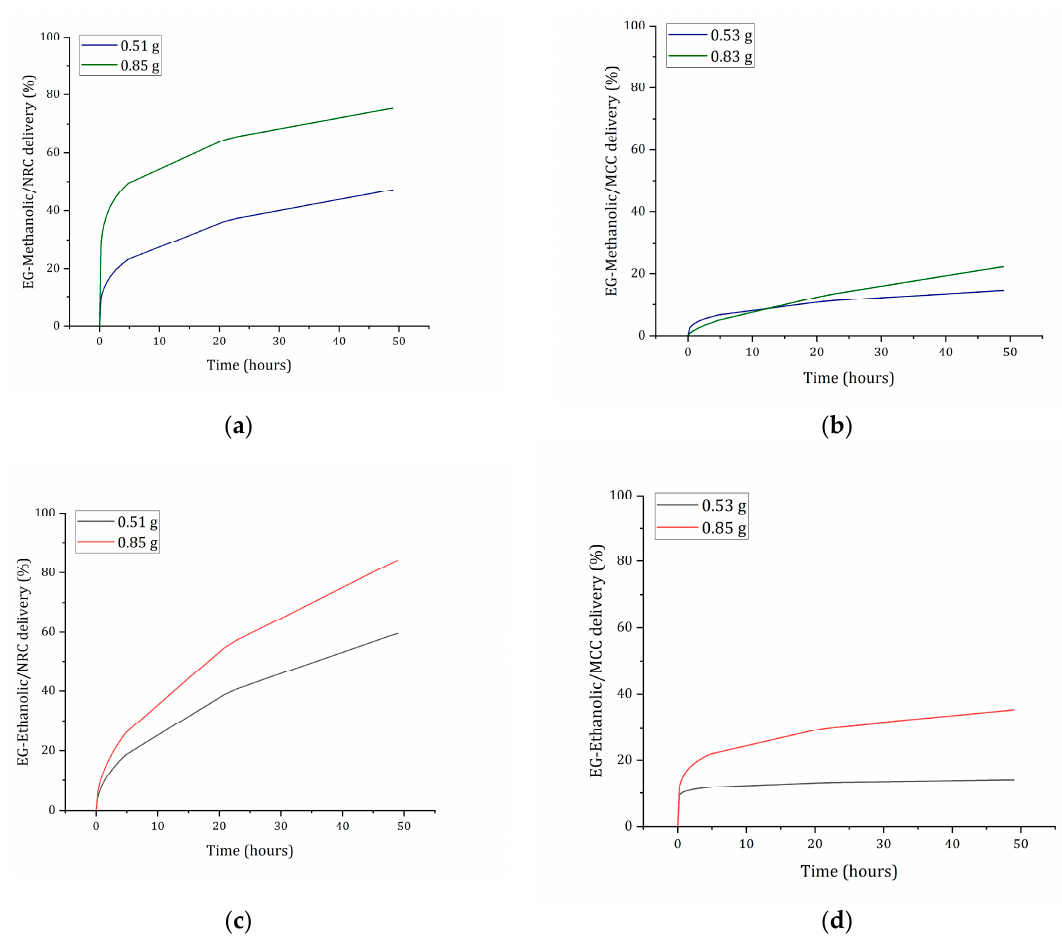
Figure 12. Plant extracts releasing data from the NRC and MCC-loaded hydrogel in PBS pH (7.4) with ( a ) EG − methanolic/NRC, ( b ) EG − methanolic/MCC, ( c ) EG − ethanolic/NRC, and ( d ) EG − ethanolic/MCC hydrogel delivery profiles.